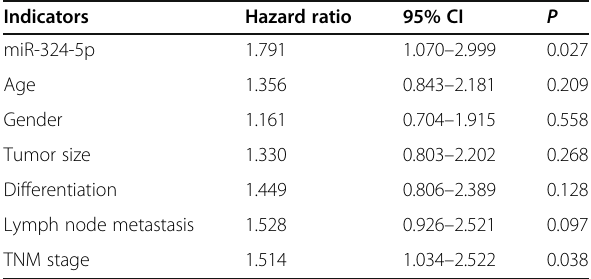
Table 2 Cox regression analysis for the overall survival of patients with gastric cancer